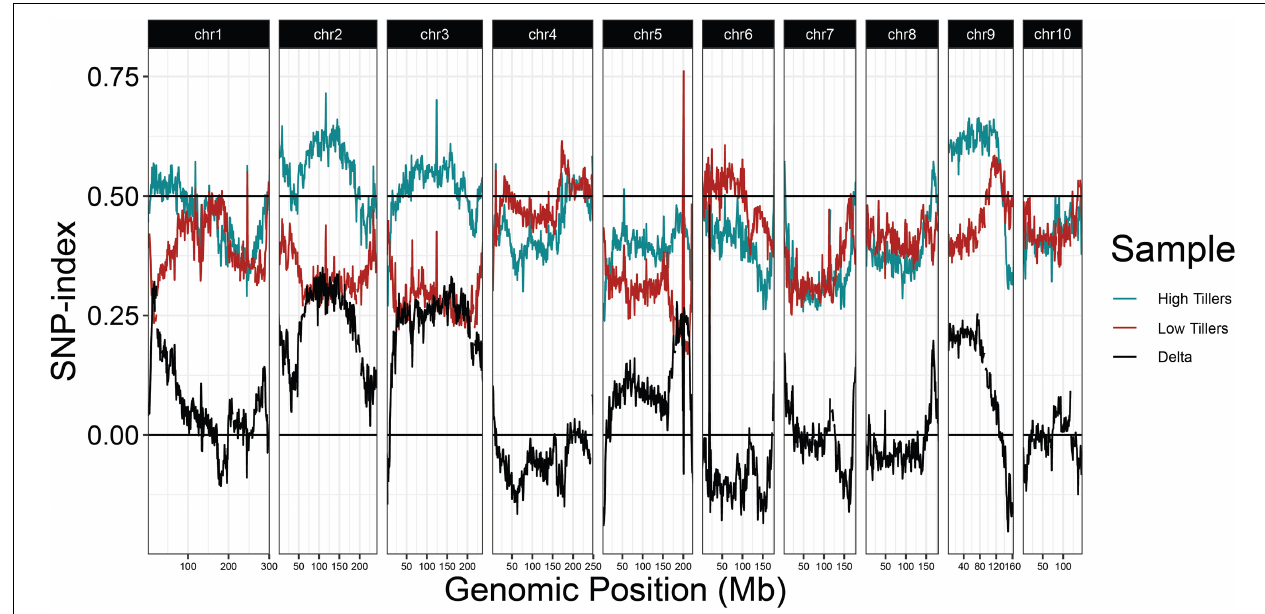
FIGURE 5 | QTL-seq for tiller number supports numerous tillering QTL in the 2019 P39/“Gigi” F 2 field population. Average SNP-index per 1 Mb window is plotted across all ten chromosomes. Lines display SNP-index in high (blue) and low (red) tiller bulks and black is the difference between the two bulks (HT-LT).